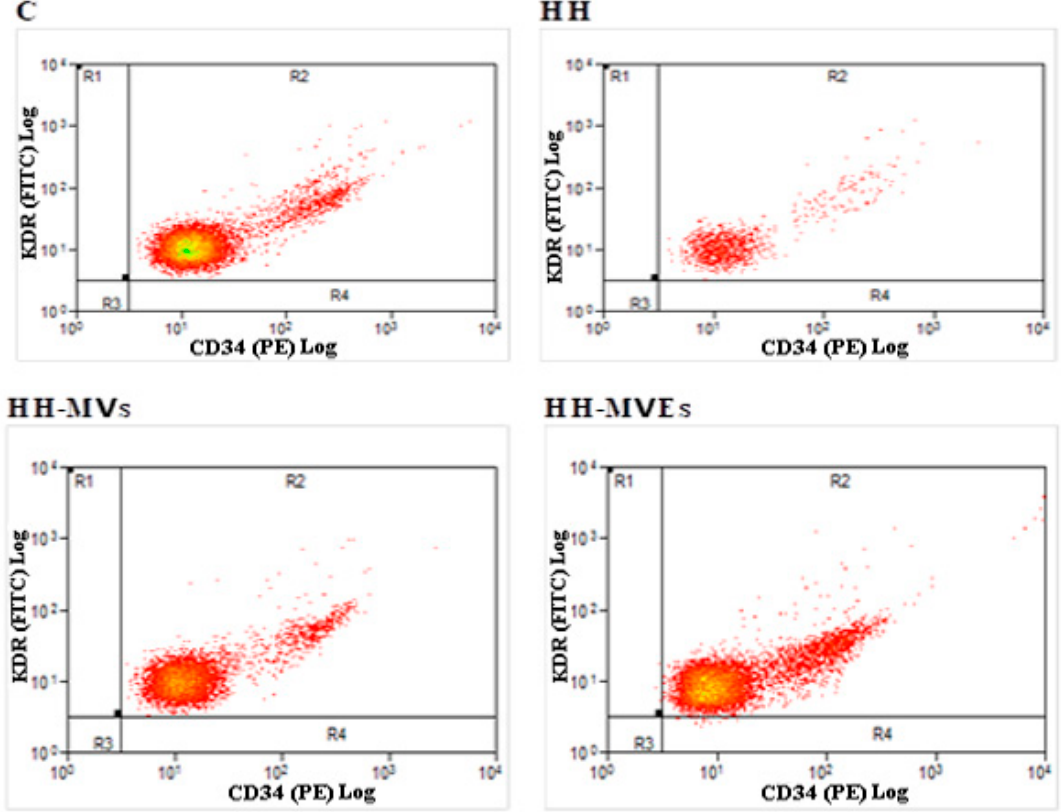
Figure 4. Specific identification of circulating endothelial progenitor cells (EPCs) isolated from all experimental groups, after 4 months of diet and treatment, by flow cytometry analysis; representative recordings for EPCs labeled with CD34 or KDR in the dark for 40 min at room